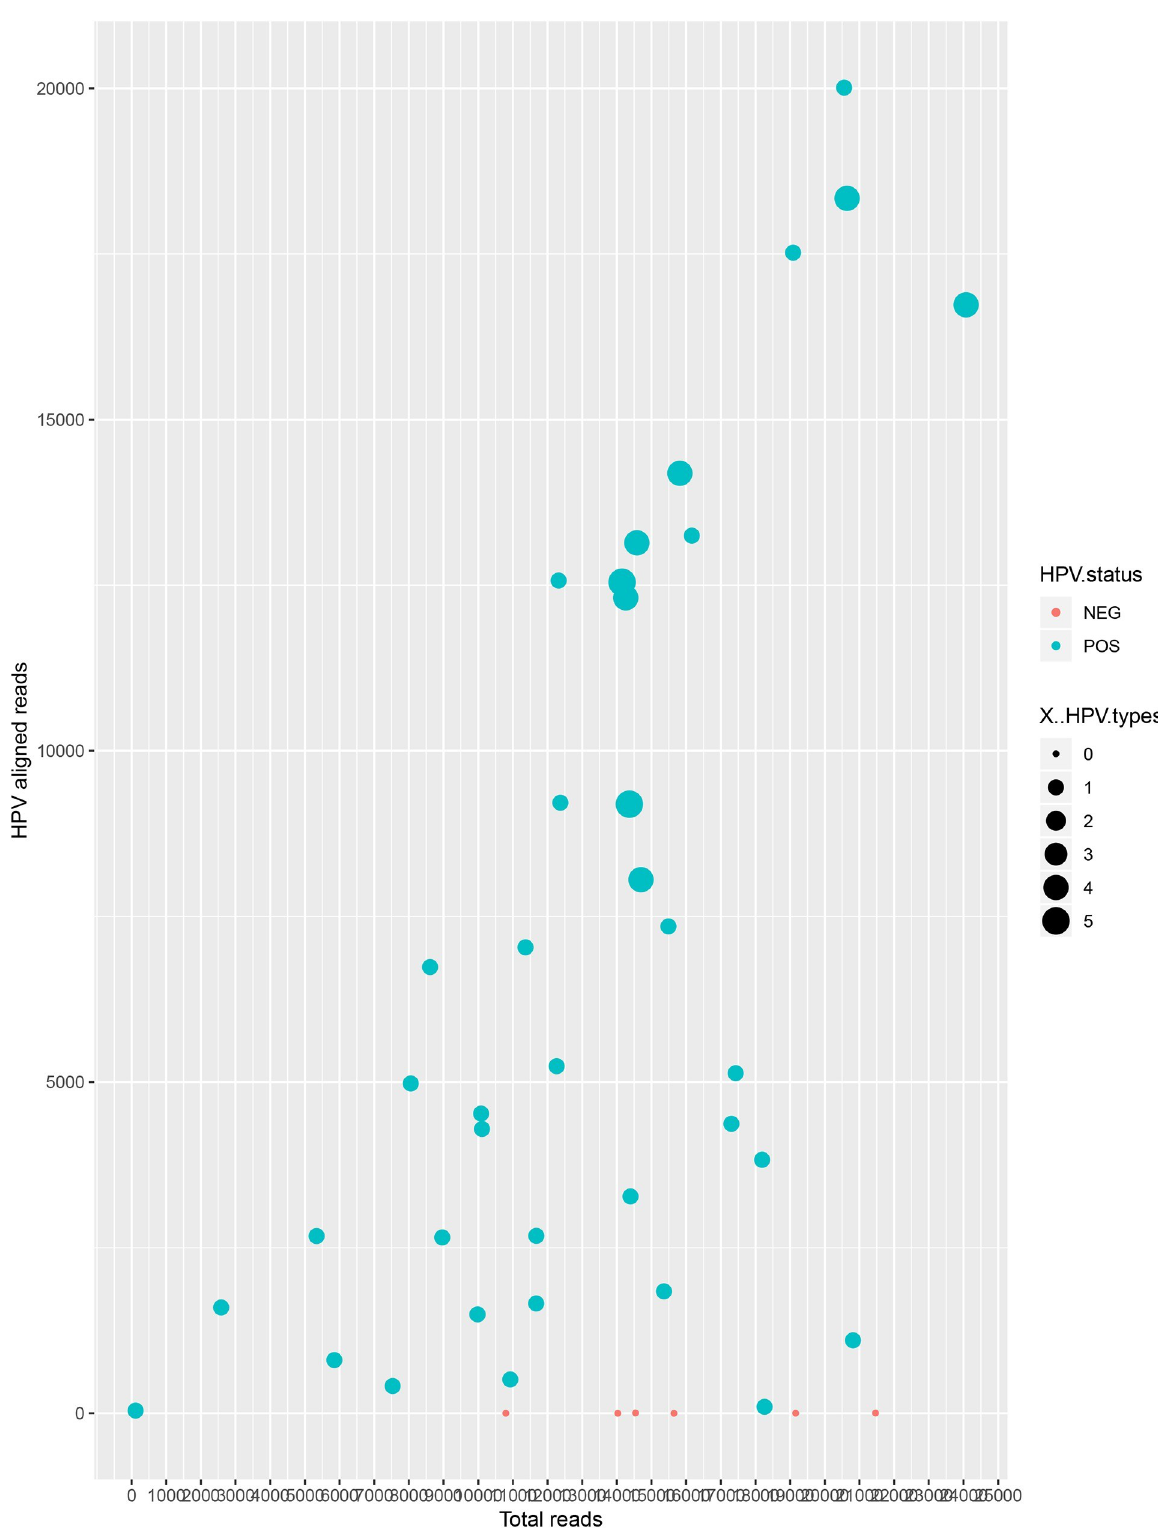
Fig 3. HPV-aligned reads vs. total number of reads according to HPV status and number of HPV types in the samples. There was no difference in total reads number between positive samples (blue dots) and negative samples (red dots). In contrast, alignment of HPV reads